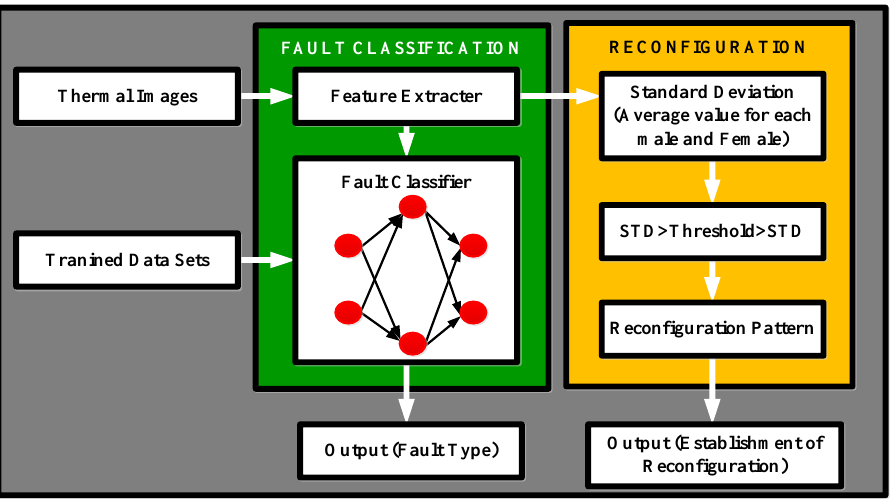
Figure 12. Block diagram of the proposed work. The neural network has the two kinds of data sets, i.e., trained data sets (known data) and testing data sets (unknown data). In this work, the trained data set was obtained from thermal images of healthy PV modules and faulted PV modules. Under different irradiation conditions (from minimum to maximum), the thermal images were captured using the Flir T-420bx thermal camera. The features of the thermal images were extracted using an image processing tool in MATLAB. These features were fed to the neural networks as the trained data sets. These data sets had individual values such as healthy, shaded, cracked, partially shaded, hotspot, and delaminated PV modules. The training data set contained individual data for each kind of fault. Four image features were extracted from the thermal images and the features were mean, standard deviation (STD), entropy, and norm. The trained data were also considered the reference data for classifying faults. After the trained data set was obtained, fault classification details were given to the neural network. The trained data possess the details of various faults in the PV system, and when the testing input carries the unknown detail to the classifier, it then adjusts its weights, and the classifier compares this with the trained and testing variables and classifies the input. For analyzing the performance of the proposed fault detection method, some faults were intentionally created on the PV array. This work was validated in the 4 × 5 PV array. In the PV array, dust and talcum powder were spread over the surface of the PV modules P12, P13, P14, P22, P23, and P24. In P33 and P44, the interconnections were reversed, so that the heat would be dissipated, creates the hotspot in this location. In the position of P35 and P45, the PV modules were replaced with four-years-old panels which were almost delaminated due t poor maintenance. The PV modules P42, P43, and P44 were completely shaded by cardboard sheets. and the PV modules P21 and P31 were partially shaded. The fault classification types are provided in Table 6. If the testing variable carries the data of a healthy module, then the classifier produces an output of 1, for shaded modules the